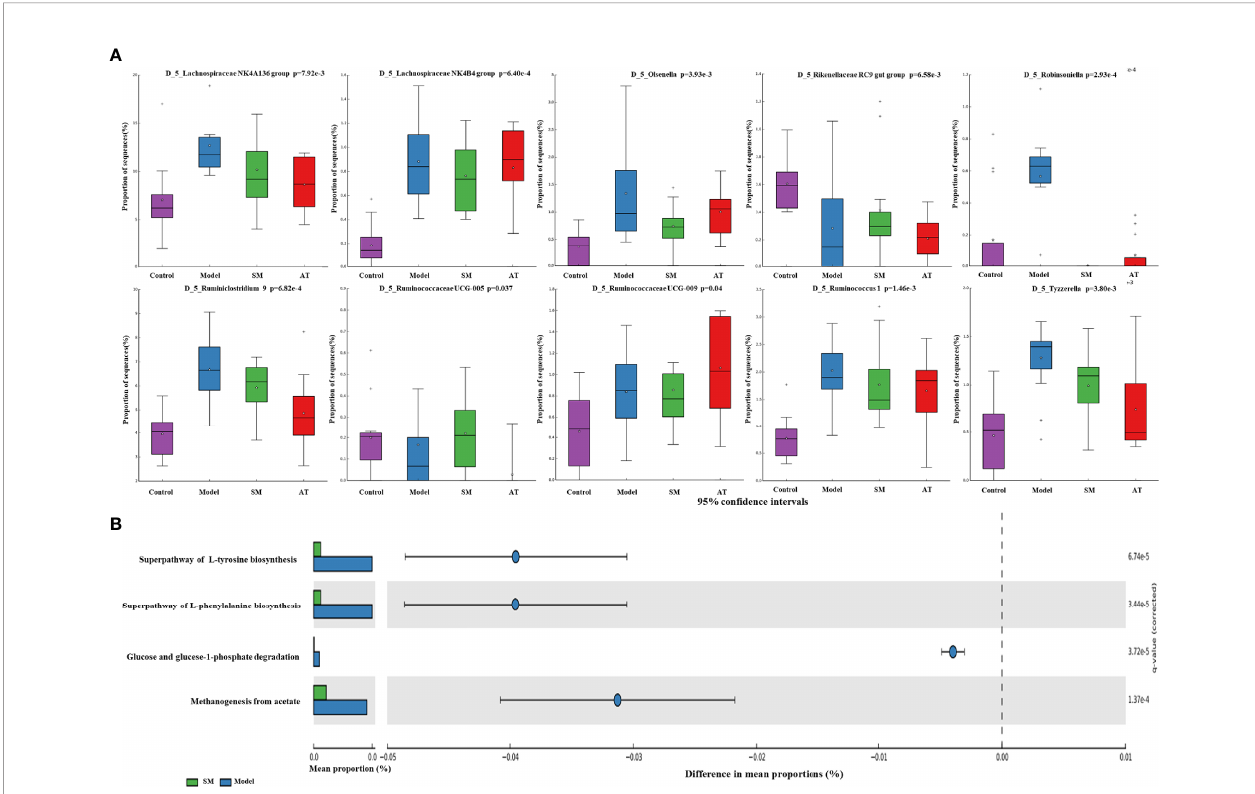
FIGURE 4 | (A) Relative abundance of the predominant bacteria at the genus level. (B) Prediction of changed METACYC pathways using PICRUST 2 analysis. * In the Figure represents mean